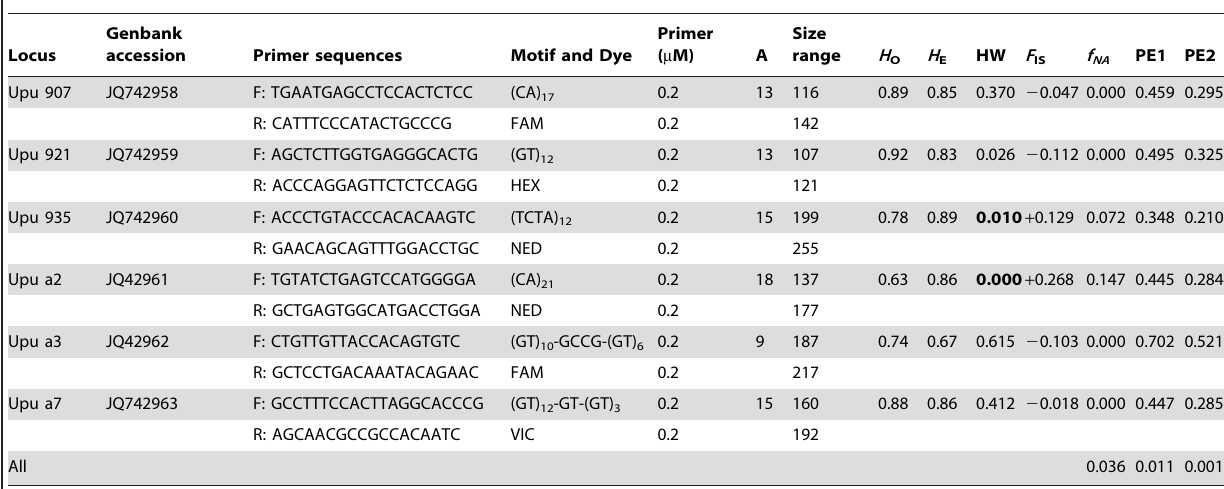
Table 1. Characteristics of six microsatellite loci developed for Upupa epops